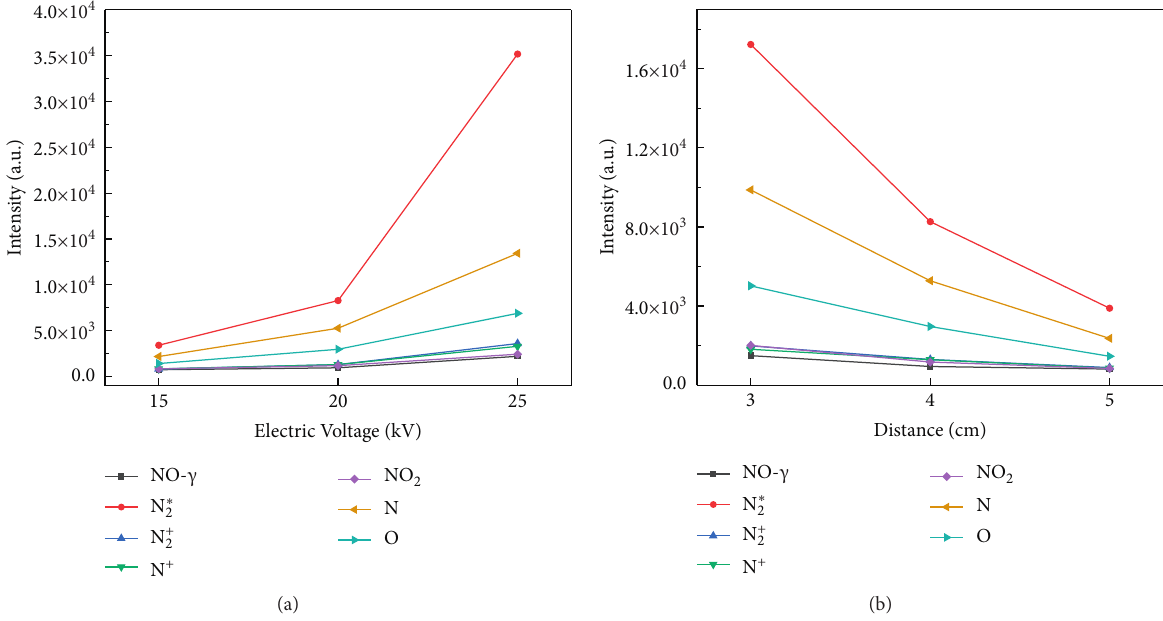
Figure 6: Plasma emission intensities at (a) needle-dielectric plate distance of 4cm and voltages of 15, 20, and 25kV and (b) voltage of 20kV and needle-dielectric plate distances of 3, 4, and 5 cm.